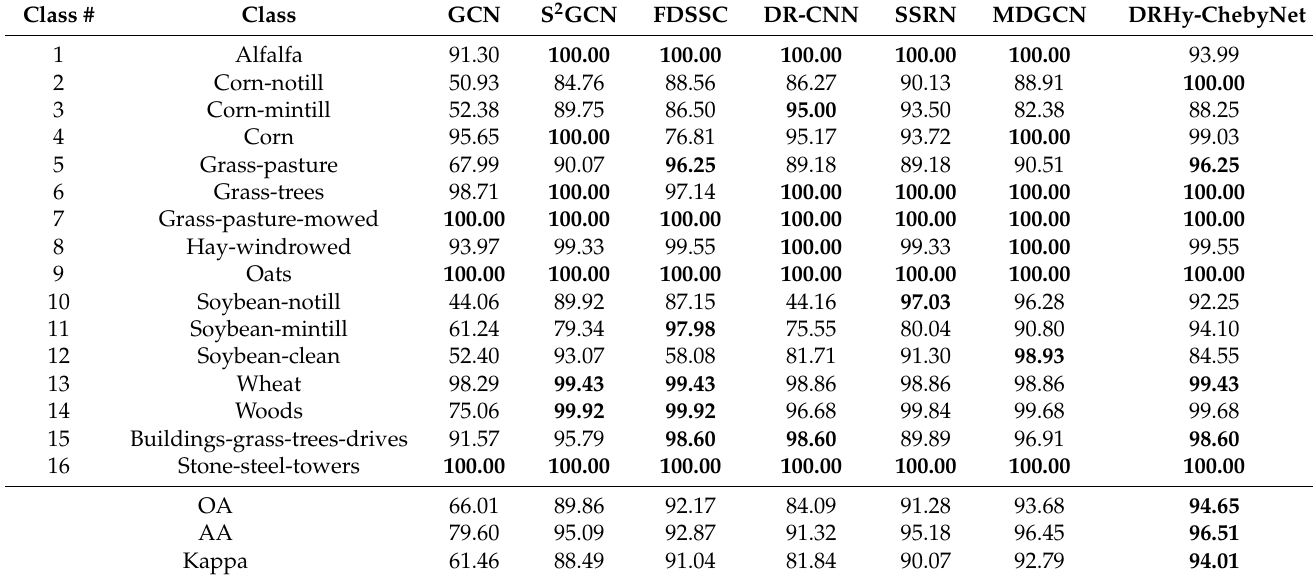
Table 3. Classification results of different methods on the Indian Pines dataset.